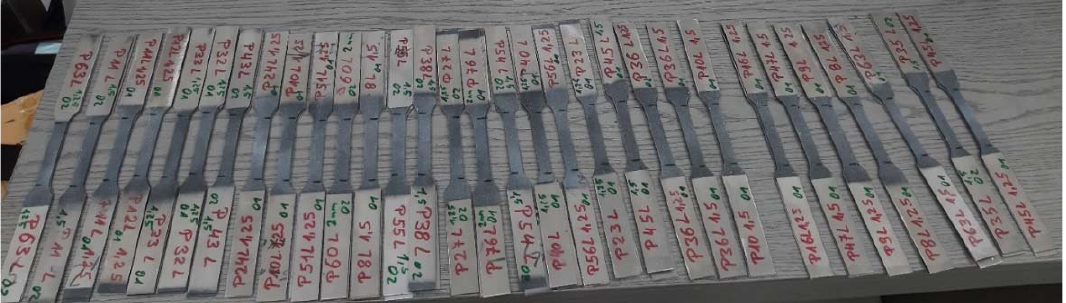
Figure 2. A photo of specimens prepared for the static tensile test with the use of a digital image correlation system (DIC).